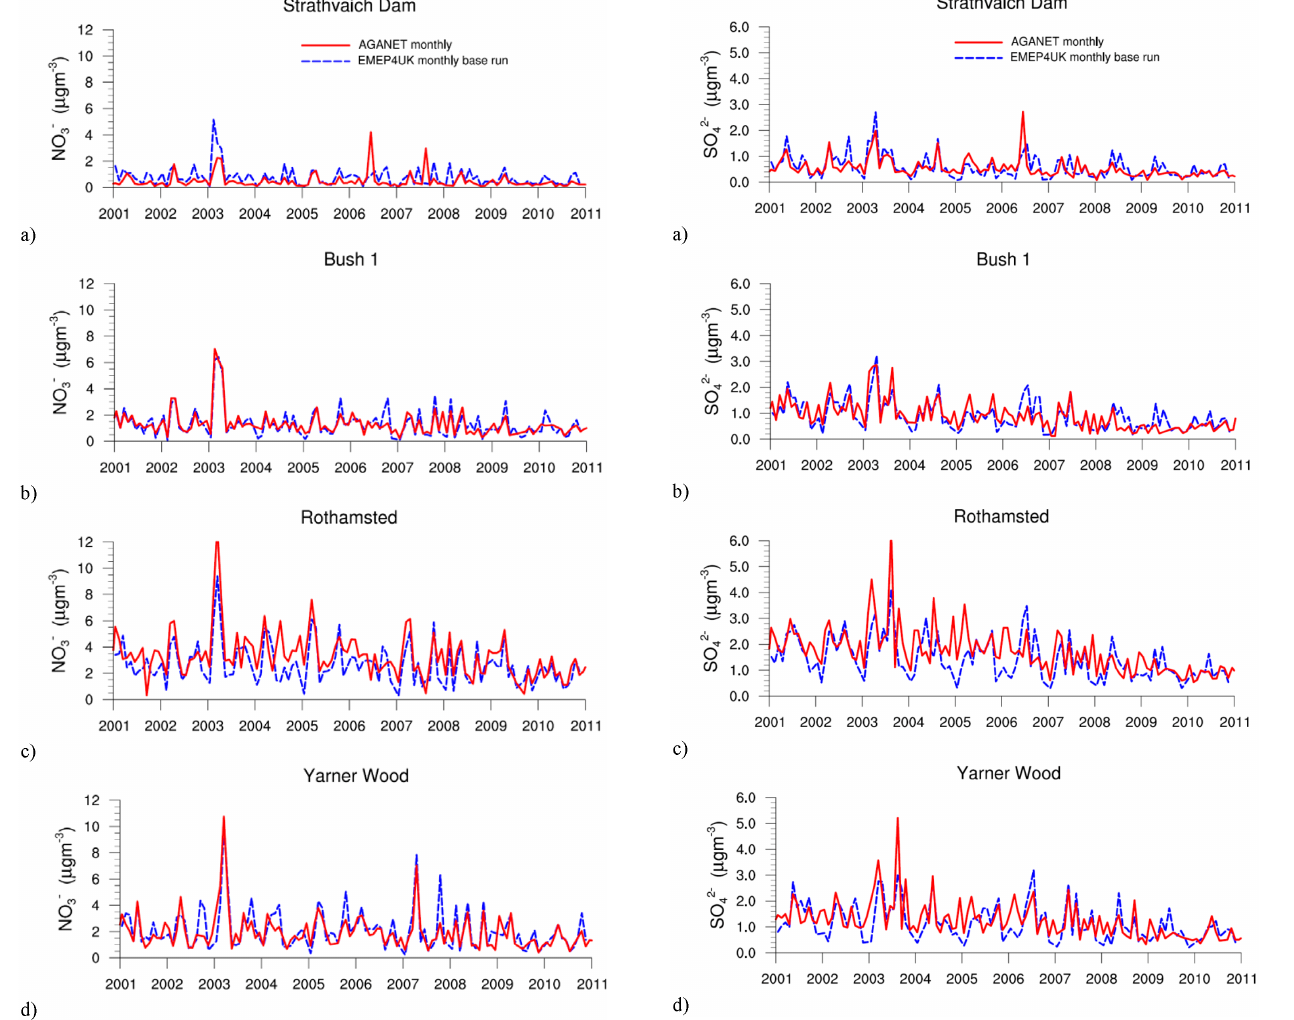
Figure 2. Monthly average surface concentrations of particulate matter nitrate, observed (red) and modelled (blue), for 2001–2010 at four sites of the AGANet network: Strathvaich Dam (northwest Scotland), Bush (central Scotland), Rothamsted (southeast Eng- land), and Yarner Wood (southwest England).